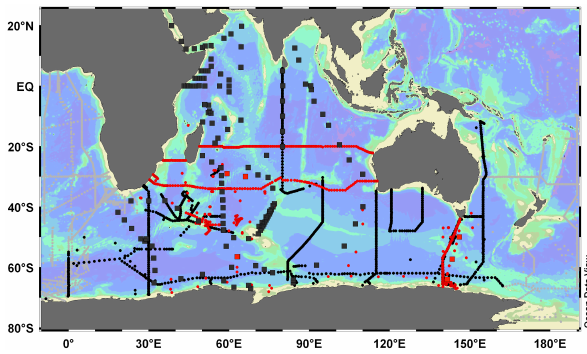
Figure 1. Map of the hydrographic stations where GLODAP and CARINA data were collected. Cruises identified in Table 1 are shown in red for CARINA data (with squares for deep OISO sta- tions). The GLODAP dataset in black includes WOCE lines (cir- cles) and historical data (GEOSECS and INDIGO, squares).